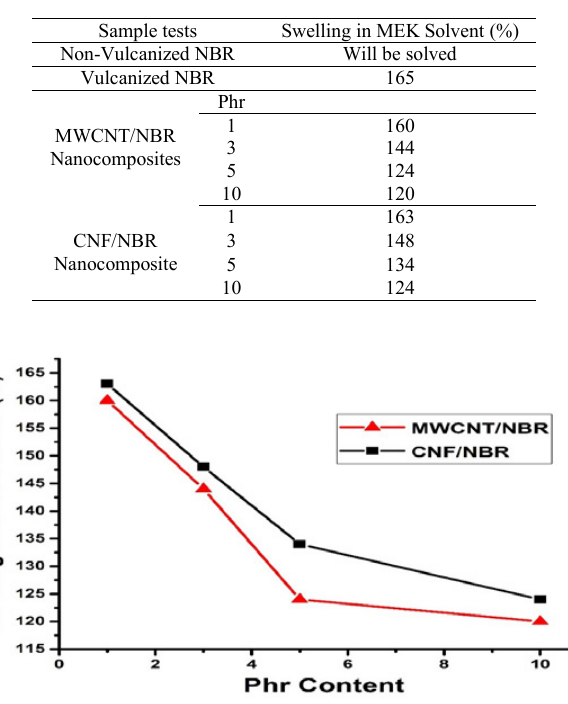
Table 6. Swelling rate of prepared nanocomposites in MEK solvent.